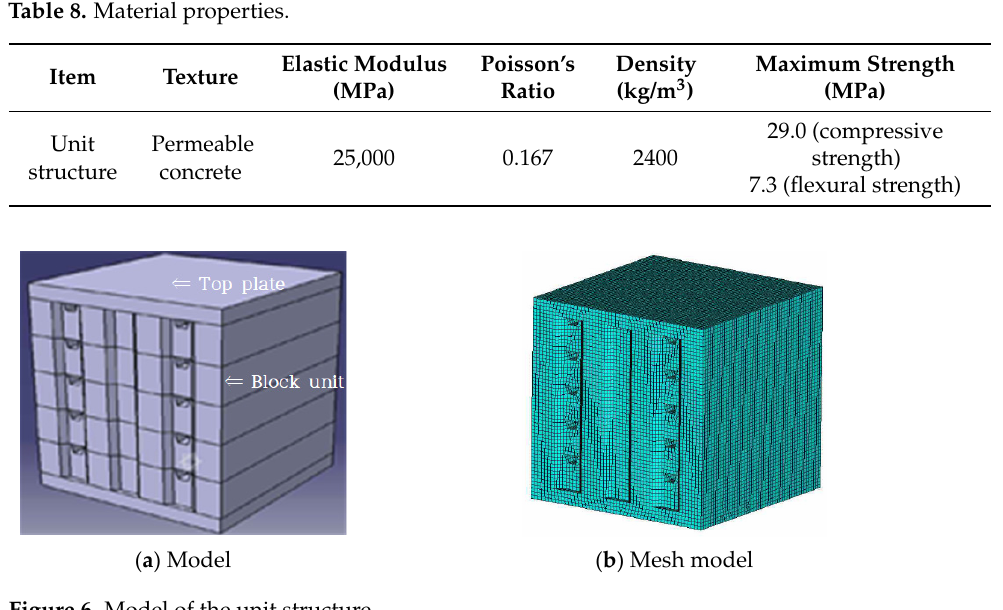
Figure 6. Model of the unit structure.